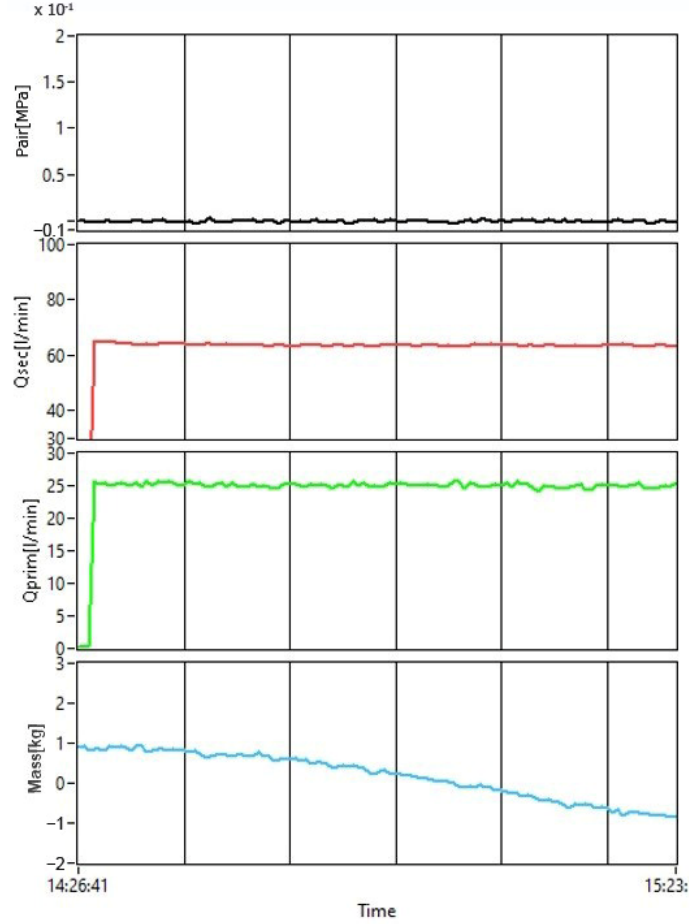
Figure 13. Evolution of pressure, primary and secondary air flow rate, and pellet consumption during the test with primary/secondary air flow rate ratio of 25/65 L/min.